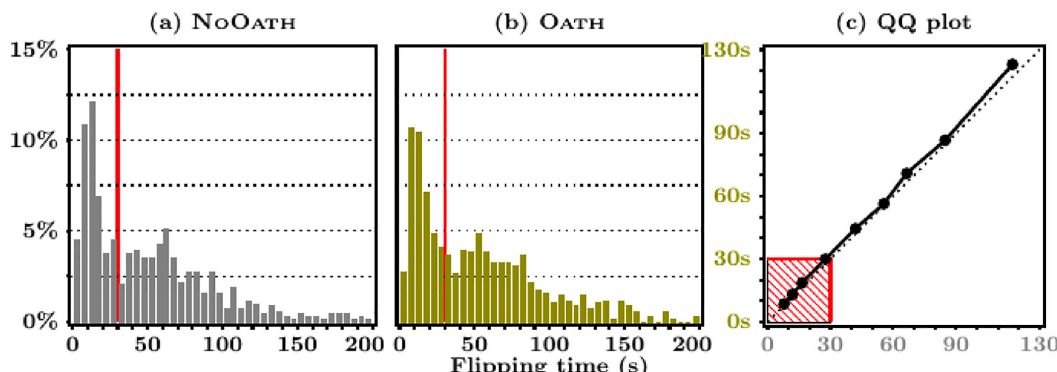
Fig 1. Flipping time distributions by treatment. Note . Panels (a) and (b) display the empirical distribution of flipping times, by treatment. A red vertical line is drawn at 30 seconds—the threshold defining shirkers. 35 workers who spent more than 200 seconds on the coin-flipping question were dropped to construct these figures. Panel (c) reports the QQ-plot of the quantiles of the N O O ATH flipping time distribution (on the x-axis) against the O ATH one (on the y-axis). https://doi.org/10.1371/journal.pone.0244958.g001 display purposes, the figure omits those MTurkers who took more than 200 seconds). The verti- cal line displays the 30s threshold that distinguishes quick from slow responses. The data clearly indicate that, yes, a nontrivial number of MTurkers did not flip the coin as instructed, and did shirk: we observe that 42.6% ( N = 292) of MTurkers completed the task in less than 30 seconds. This is comparable to the percent of inattentive MTurkers (42%) documented by [25]. Table 2 provides evidence on lying behavior based on the distribution of reported flips. Overall, MTurkers reported an average of 6.33 heads and we reject the null hypothesis that this is less than or equal to the expected mean of five if all reporting were truthful ( p = 0.000). Fig 2 displays a more detailed comparison between reported outcomes and the truthful distribution. As shown in Panel (a), the modal response ( N = 298, 21.8%) was six (a small lie if reported dis- honestly), and 18% of MTurkers ( N = 122) reported flipping 10 heads in a row (a “big lie”). This result is similar to [27] who find that 20% of subjects “lie to the fullest extent possible” in